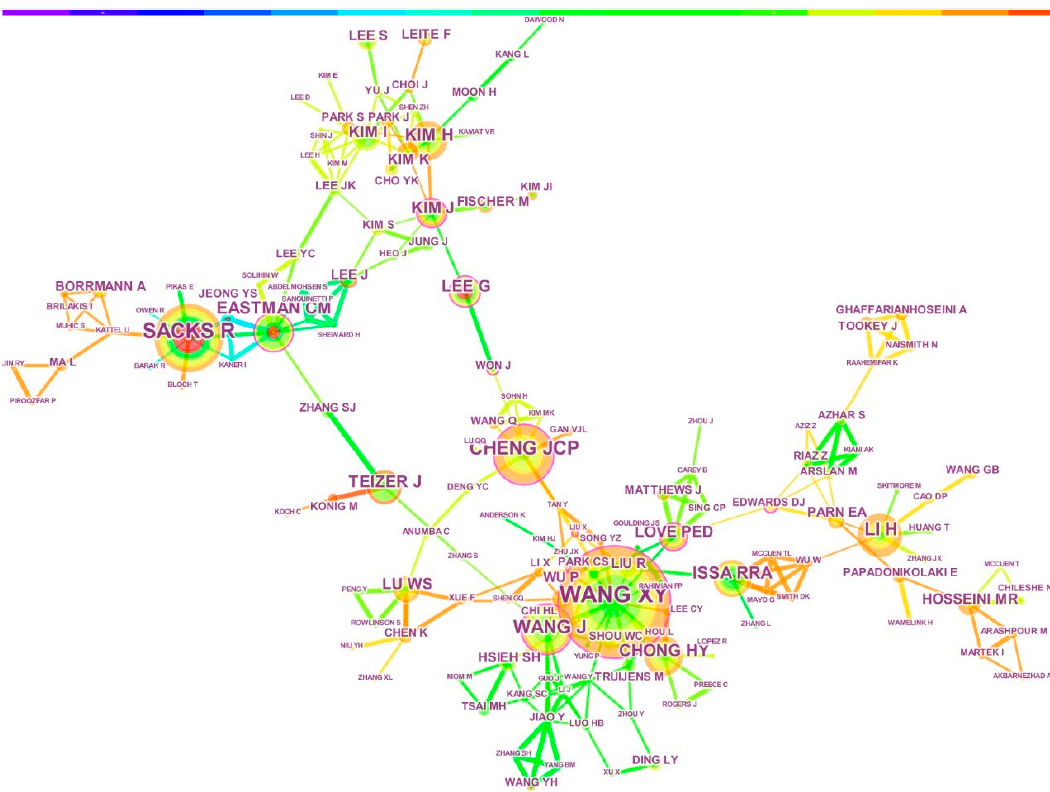
Figure 4. Co-authorship network.